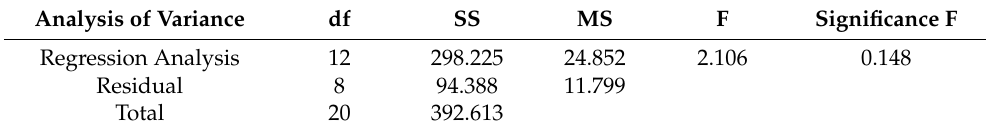
Table 2. Analysis of variance between meteorological yield and 12 meteorological factors.